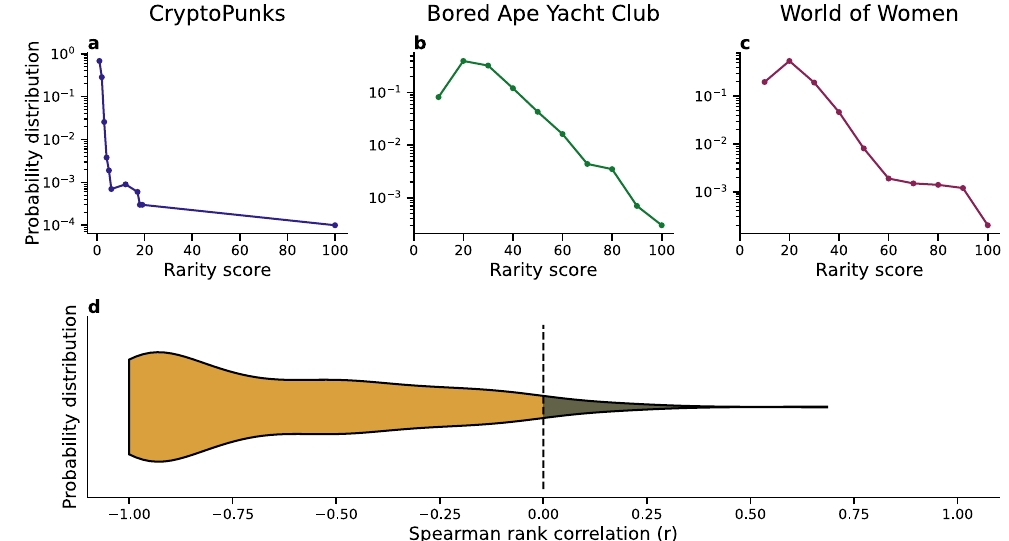
Figure 5. Rare NFTs are scarce within a collection. ( a – c ) Distribution of the rarity score of the NFTs within three collections: CryptoPunks ( a ), Bored Ape Yacht Club ( b ), and World of Women ( c ). ( d ) Violin plot of the Spearman Rank correlation computed between the rarity score and the number of NFTs with that score. 96% of the collections have a Spearman rank r ≤ 0 (black dashed